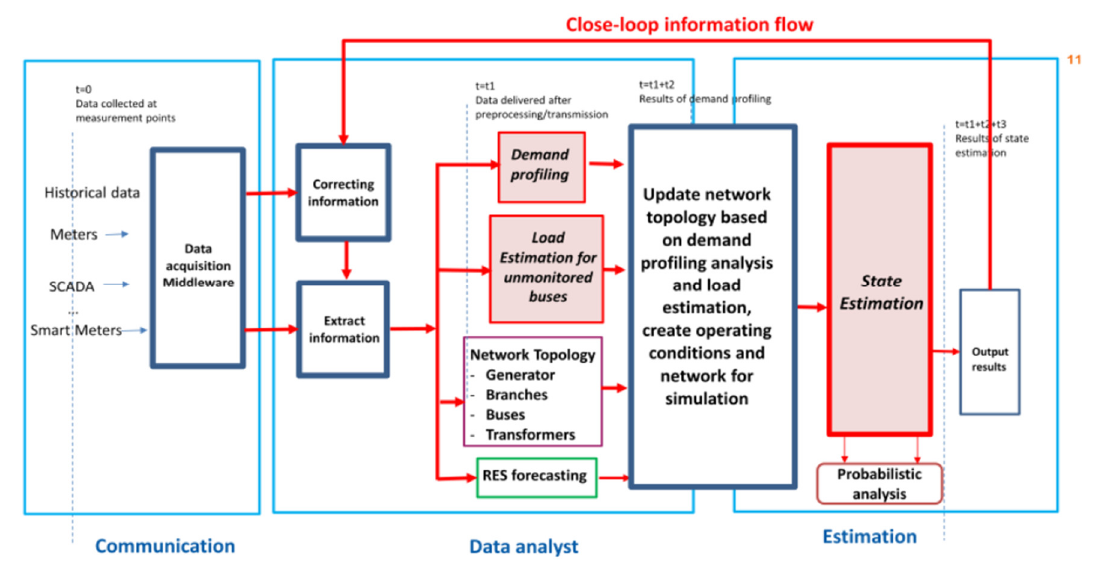
Figure 3. Illustration of data and information flow in network analysis .